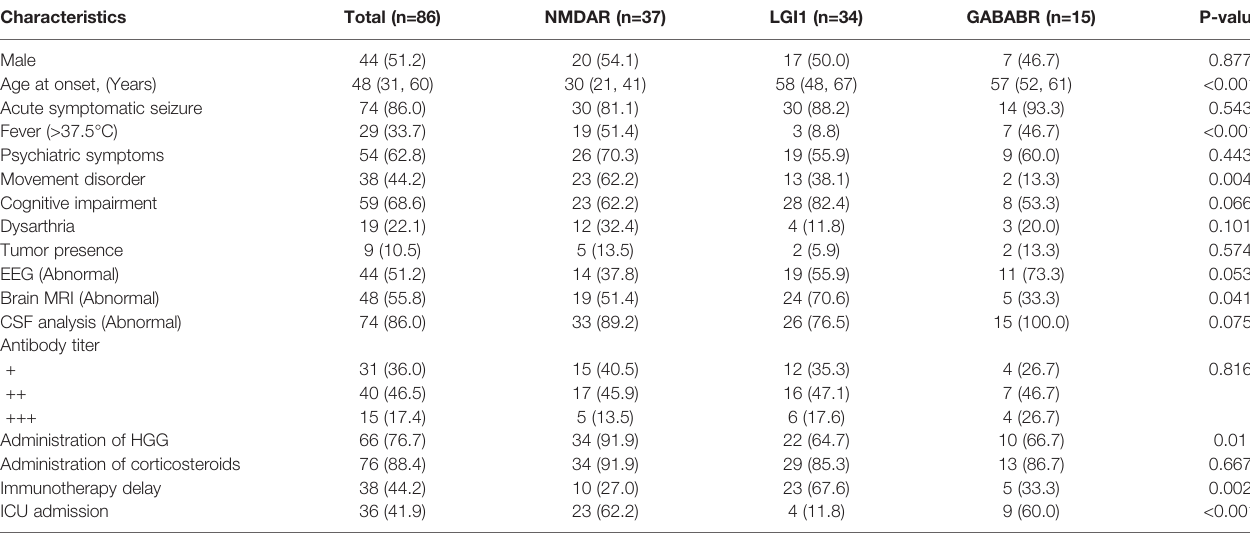
TABLE 1 | Patient characteristics by type of